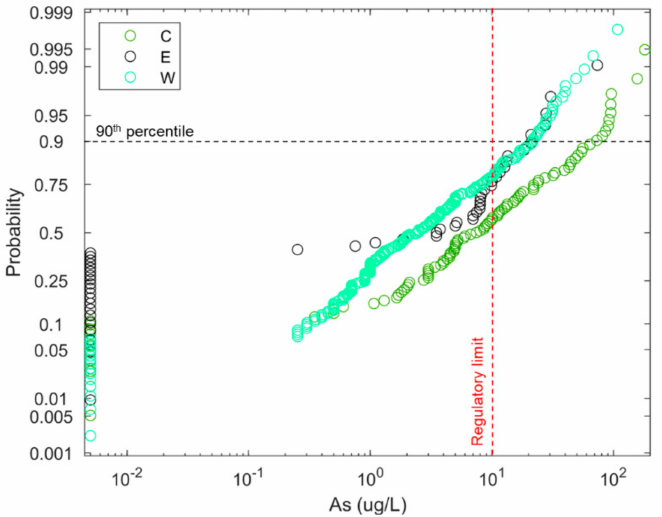
Figure 4. Probability plots of median As concentrations for each piezometer from all the sites (filtered As data), after the removal of outliers likely representing anthropogenic influences; the data are divided with respect to the three geological sectors (C: central, E: eastern, W: